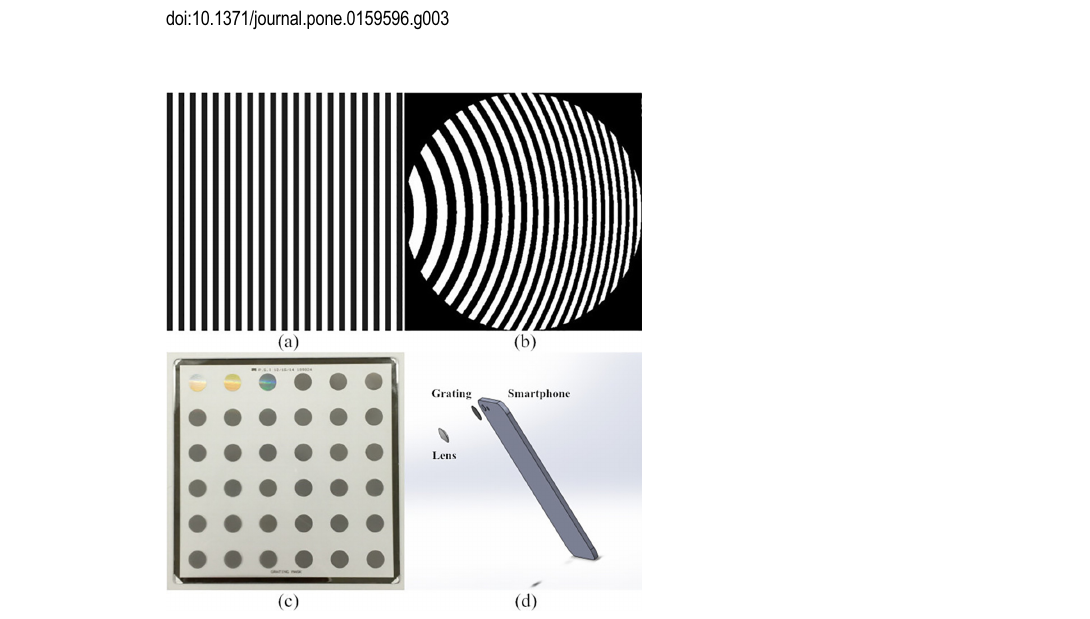
Fig 3. Resulting image of using the smartphone-based system to image the USAF resolution target. The system demonstrates the capability of resolving the 6 th element of group 7 on the resolution target, which has a line width around 2 μ m.